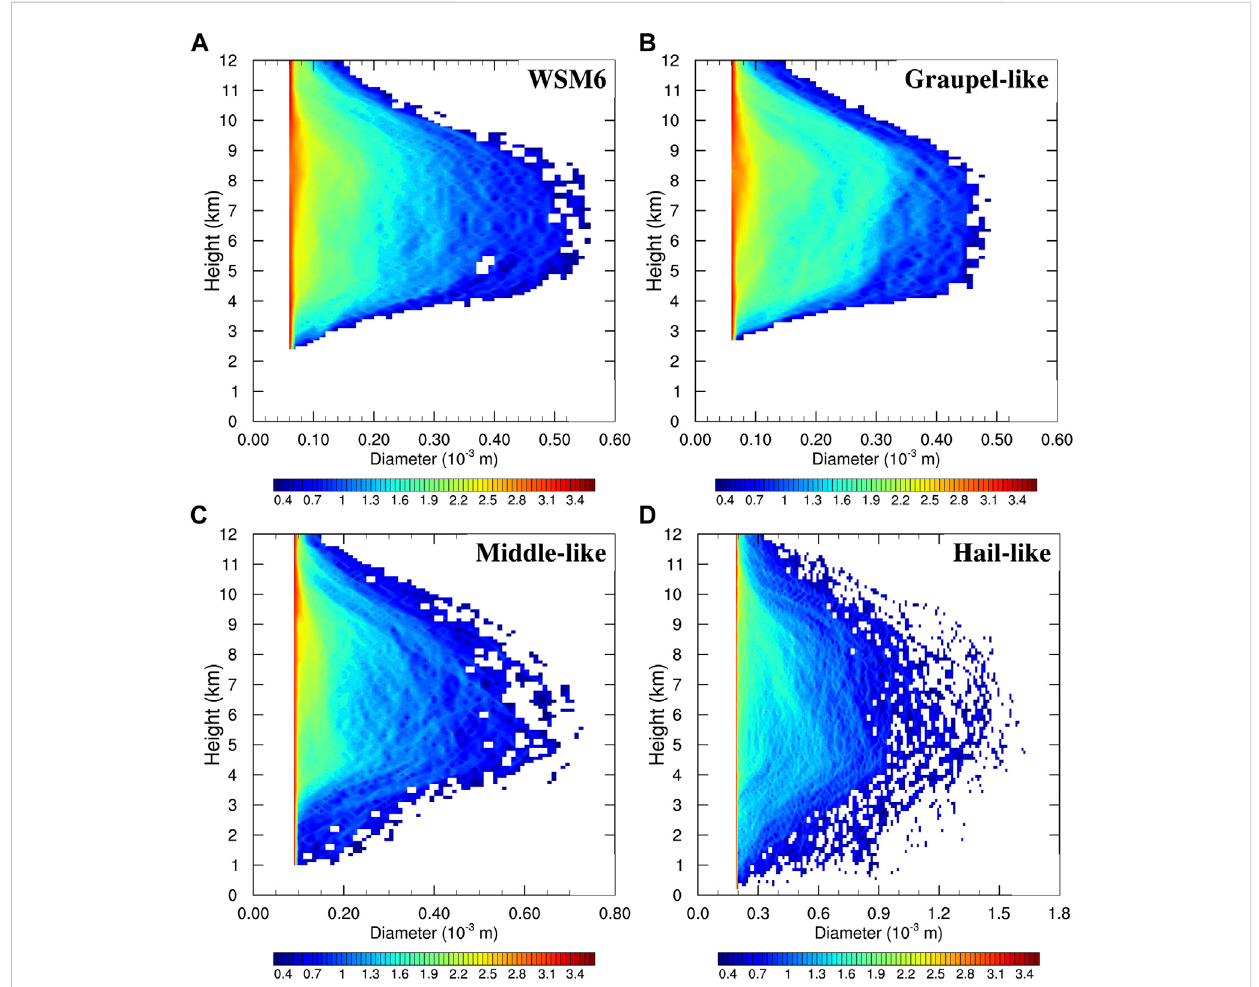
FIGURE 11 Contoured frequency by altitude diagrams (CFADs) of horizontally and temporally averaged volume-weighted mean diameter of graupel particles (10 − 3 m)for (A) WSM6, (B) WSM6-Graupel-Like, (C) WSM6-Middle-Like and (D) WSM6-Hail-Likeexperiments.Theareaaveraging wasovergreysolidbox in Figure 6A, and temporal averaging was from 0900 UTC to 1700 UTC on 9 August 2020. Note that the ranges of abscissa differ between experiments and the colour bar for the increasing logarithmic values [from blue (1) to red (10 4 )] is used to describe the occurrence